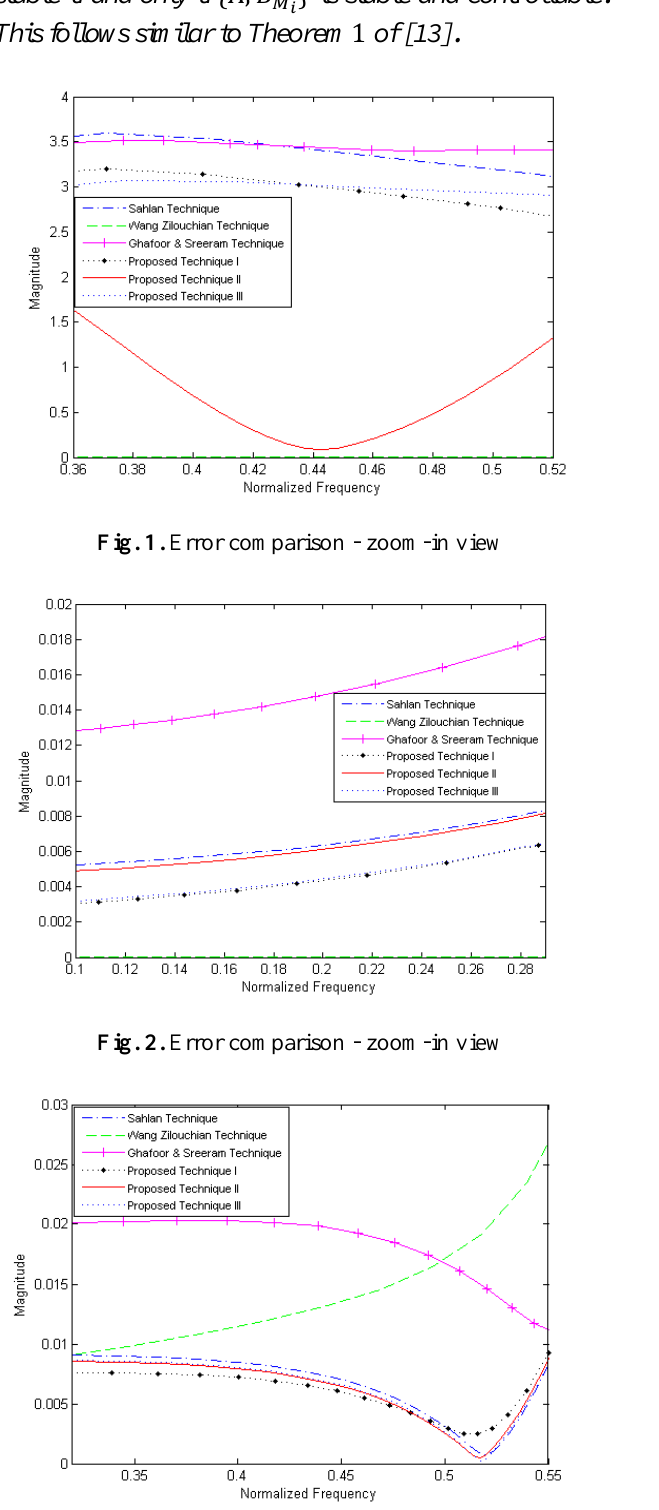
Fig. 3. Error comparison - zoom-in